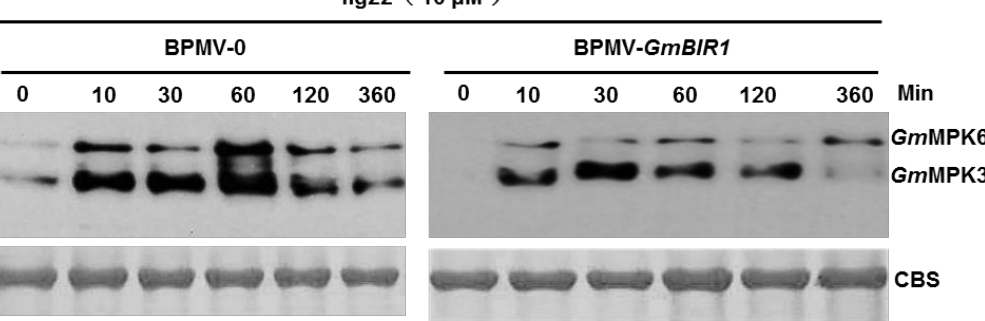
Figure 5. Silencing GmBIR1 reduces the activation of Gm MPK3/ Gm MPK6 in response to flg22 treatment. Leaf discs from indicated soybean plants were incubated on moist filter paper for 24 h to allow recovery from wounding before being treated with 10 μM flg22 or diluted DMSO. The kinase activities were detected by Western blotting using Phosph-p44/p42 MAP Erk1/2 antibody. Coomassie Blue–stained gel (CBS) used as loading controls. The experiment was repeated 3 times with similar results.